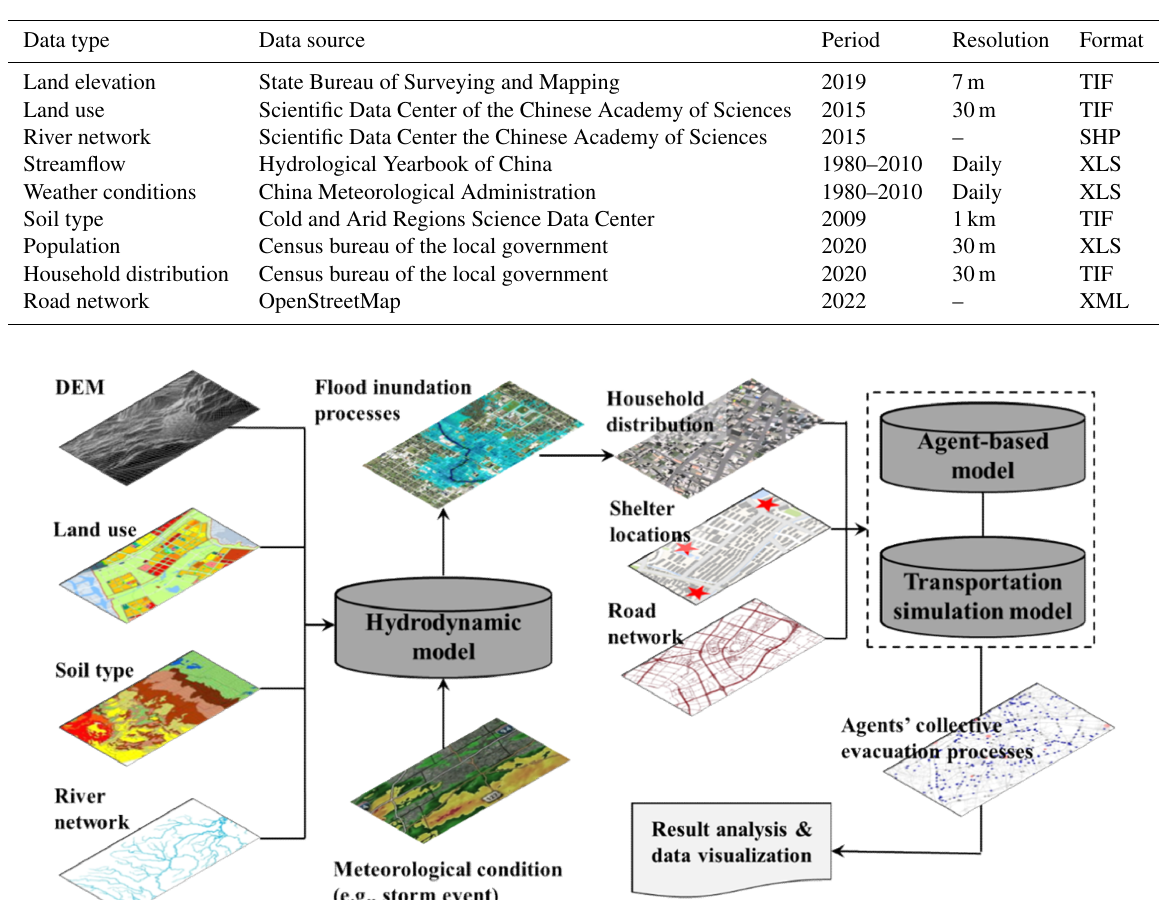
Figure 5. Data sources and flowchart of the integrated modeling framework.